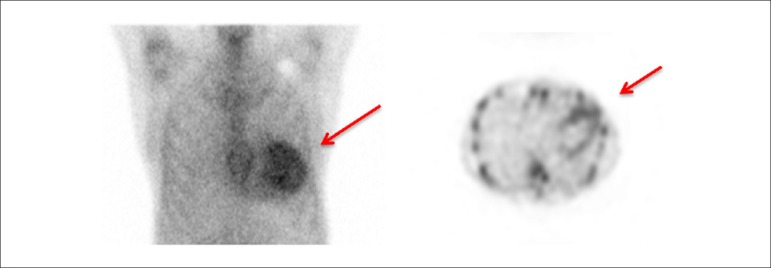
Scintigraphy with Pyrophosphate-99mTc (left: planar imaging of the anterior thorax; right: axial cross section of the tomography image) demonstrated severe radiopharmaceutical uptake in the left ventricle (arrows) in a patient with confirmed transthyretin cardiac amyloidosis.